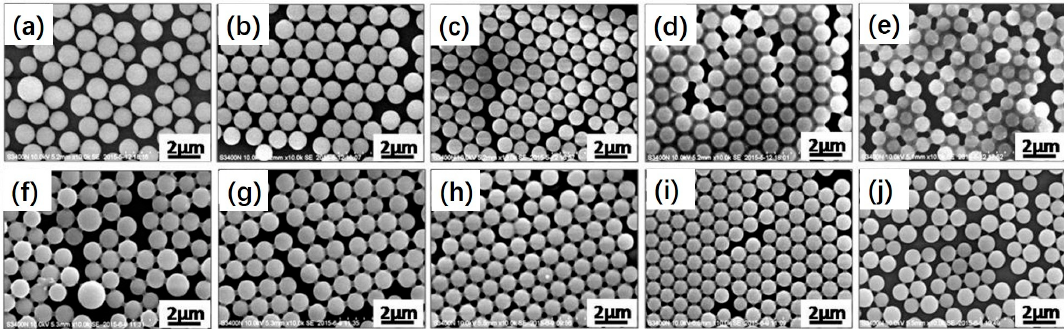
Figure 6. SEM images of polymeric microspheres prepared by photoinitiated RAFT dispersion polymerization of MMA at different Poly( N -vinylpyrrolidone) (PVP) concentrations (5–25 wt %) with either ( a – e ) 2 or ( f – j ) 6 wt % MAA: ( a , f ) 5 wt % PVP, ( b , g ) 10 wt % PVP, ( c , h ) 15 wt % PVP, ( d , i ) 20